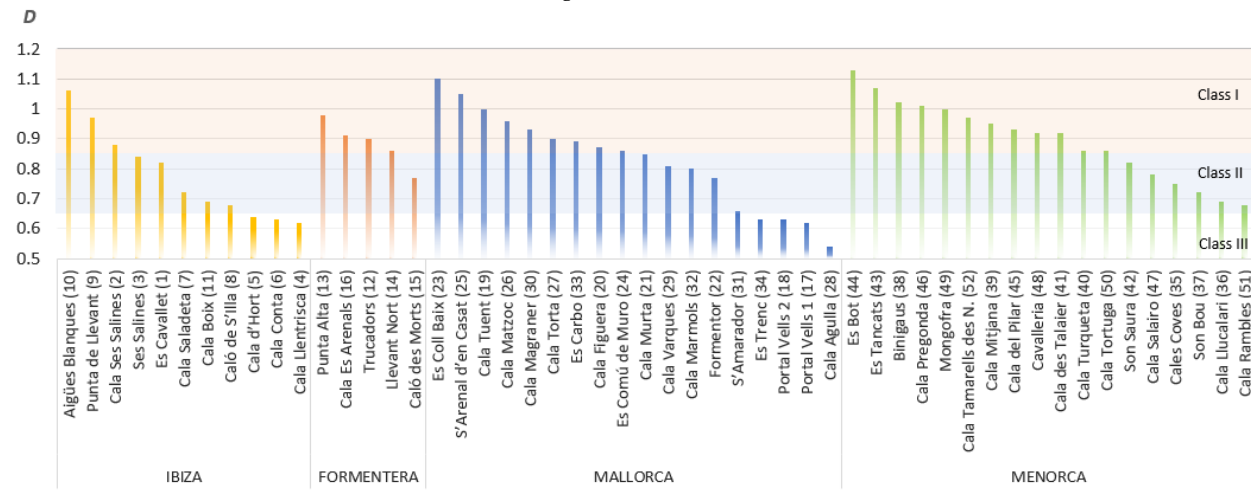
Figure 7. “D” values (CSES method) obtained at the 52 sites investigated in the Balearic Islands. (a) Physical parameters